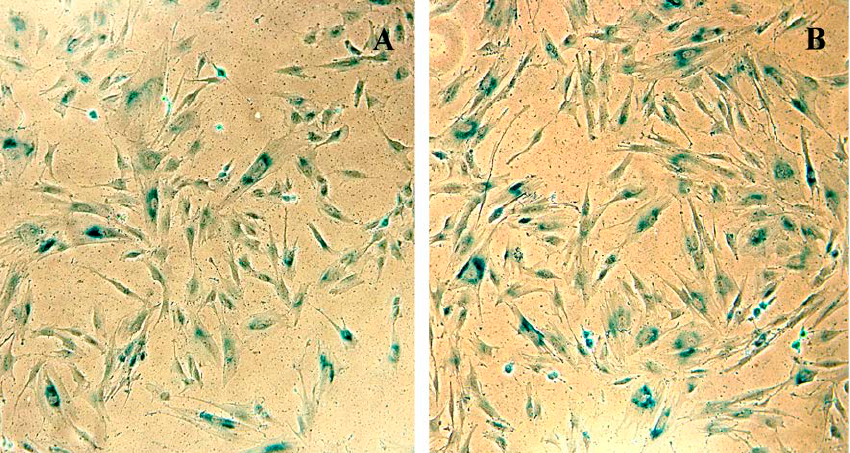
Figure 10. eMSC that survived sublethal heat shock (SHS-SP) exhibit SA- β -galactosidase expression at passage 30. ( A ) X-gal staining of parental cells. ( B ) X-gal staining of cells that survived heat